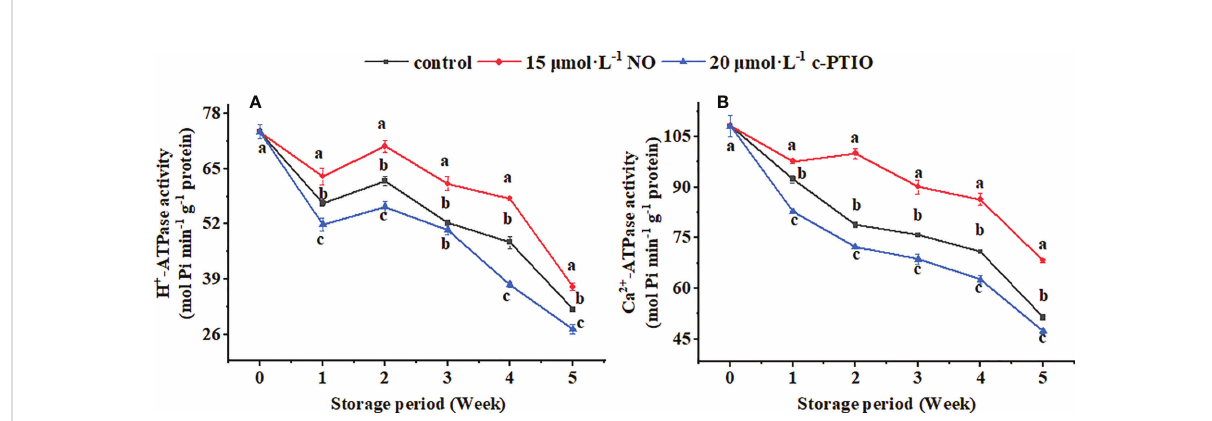
FIGURE 4 Changes in the H + -ATPase (A) and Ca 2+ -ATPase (B) activities in peach mitochondria. Error bars indicate standard errors ( n = 3). Different letters indicate signi fi cant differences among different treatments ( P <